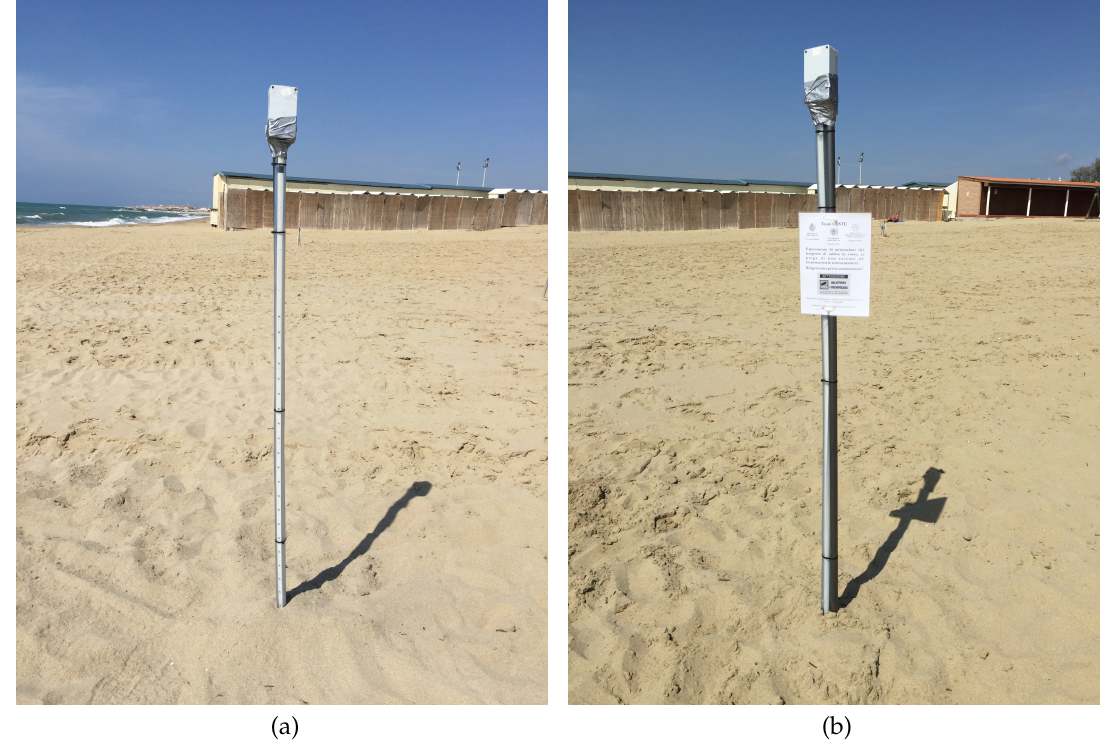
Figure 6. The two deployed sensor nodes: ( a ) Pole 1 and ( b ) Pole